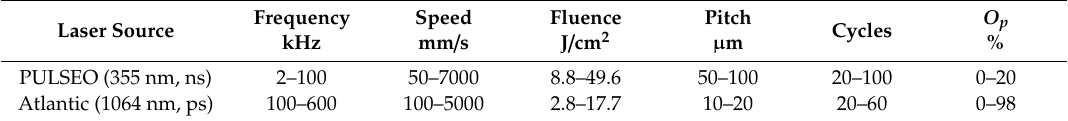
Table 1. Range of the di ff erent process parameters used. ns = nanosecond; ps =